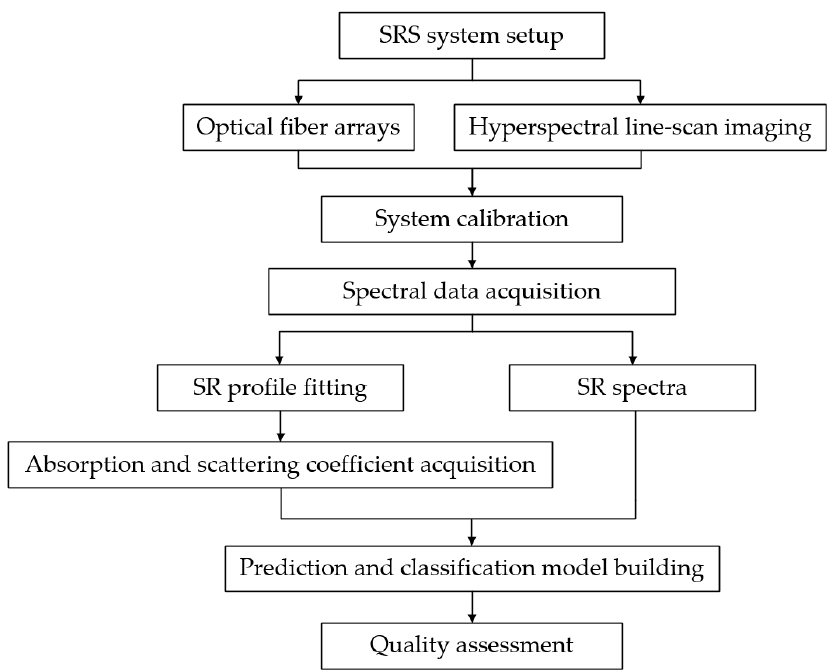
Figure 2. Flowchart of complete experimental procedures based on the spatially resolved spec- troscopy measurement system. (SRS = spatially resolved spectroscopy; SR = spatially